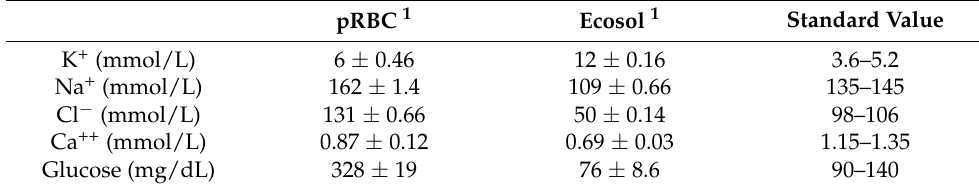
Table 1. Mean perfusate electrolyte and glucose concentrations compared to standard values.